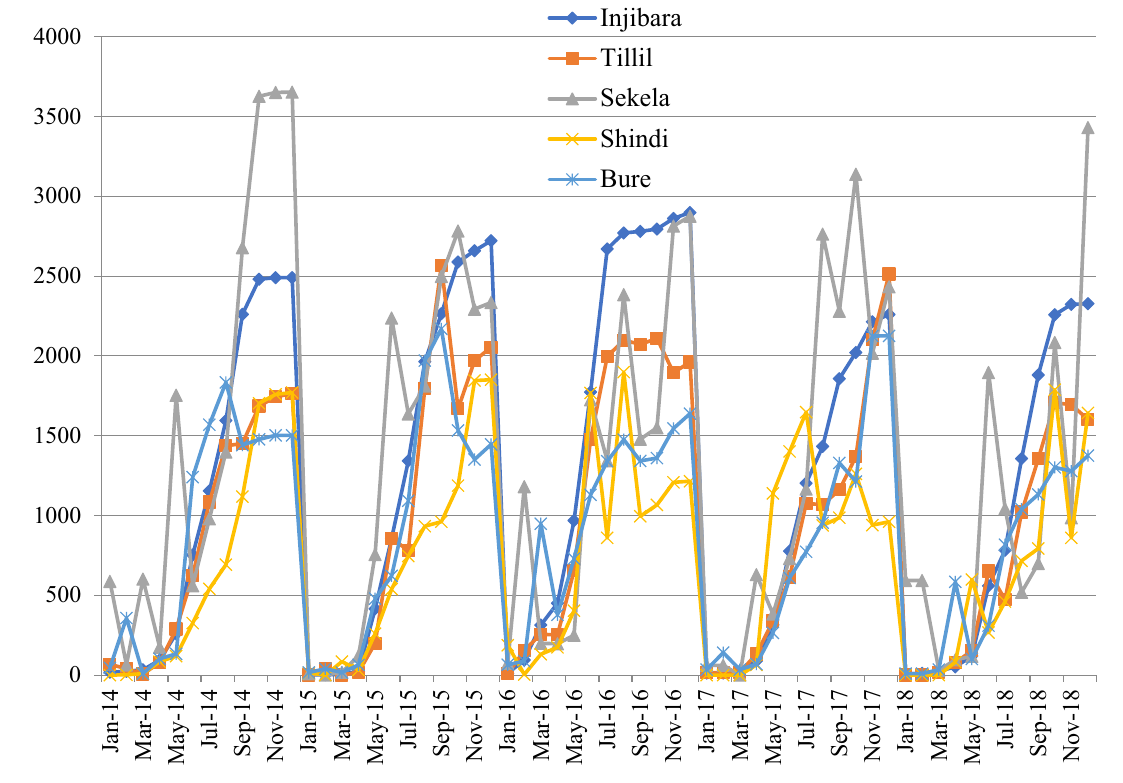
Fig. 5 Homogeneity and trend test of five rainfall station (2014–2018) years PX ′ represents corrected precipitation at station x , PX represents initially recorded precipitation at station x , M ′ represents the corrected slope of the double mass curve, and M represents the actual gradient of the double mass curve shown in Fig. 6.